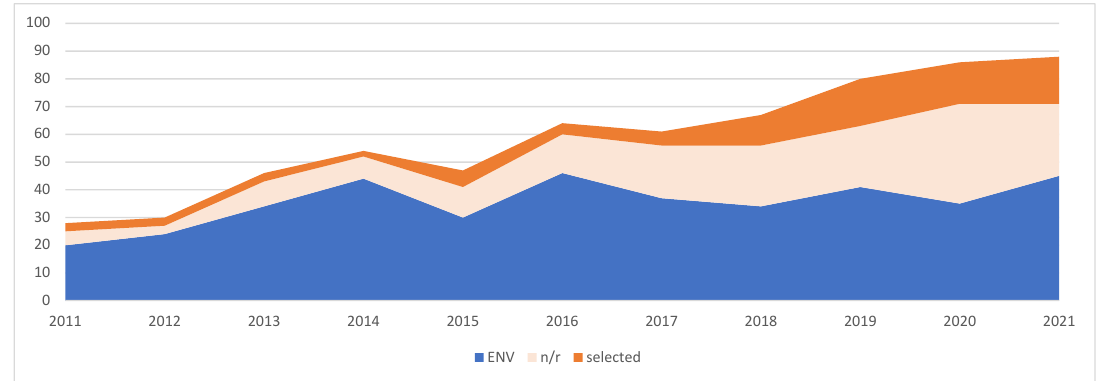
Figure 4. Number of publications per year of the “ water SEE ” sample. Adapted from Scopus.